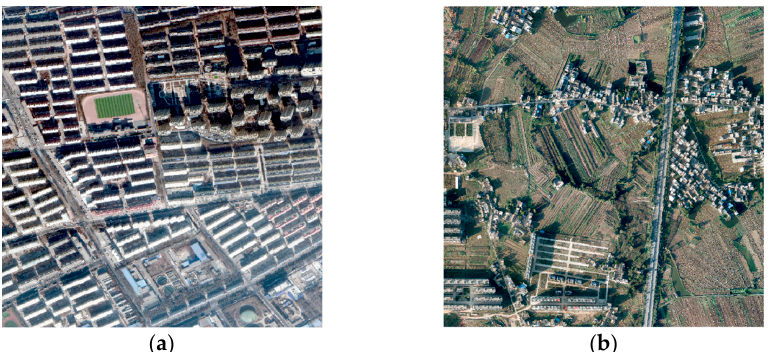
Figure 4. Two remote sensing images with larger area as target domains. ( a ) The first image for urban area. ( b ) The second image for suburban area.